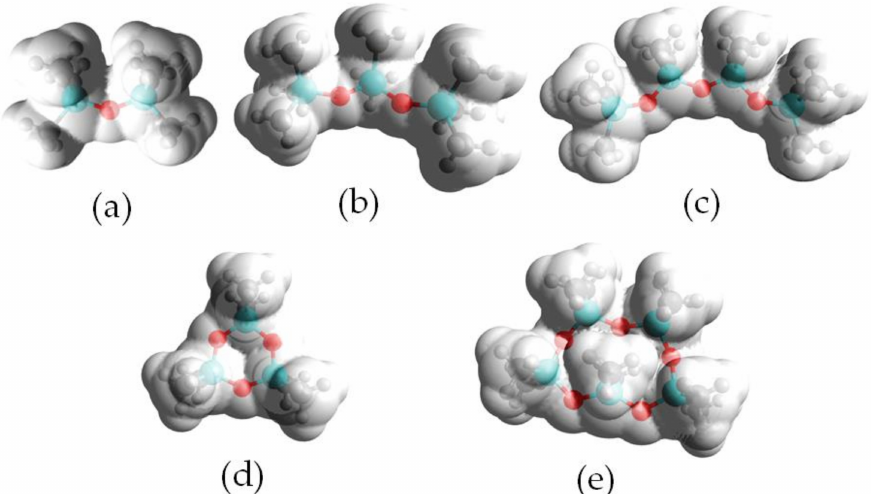
Figure 5. ESP mapped onto total electron density with an isovalue of 0.001 for siloxanes, i.e., ( a ) L2, ( b ) L3, ( c ) L4, ( d ) D3 and ( e ) D5. Blue color represents positive charges, red color represents negative charges, and white color represents neutral